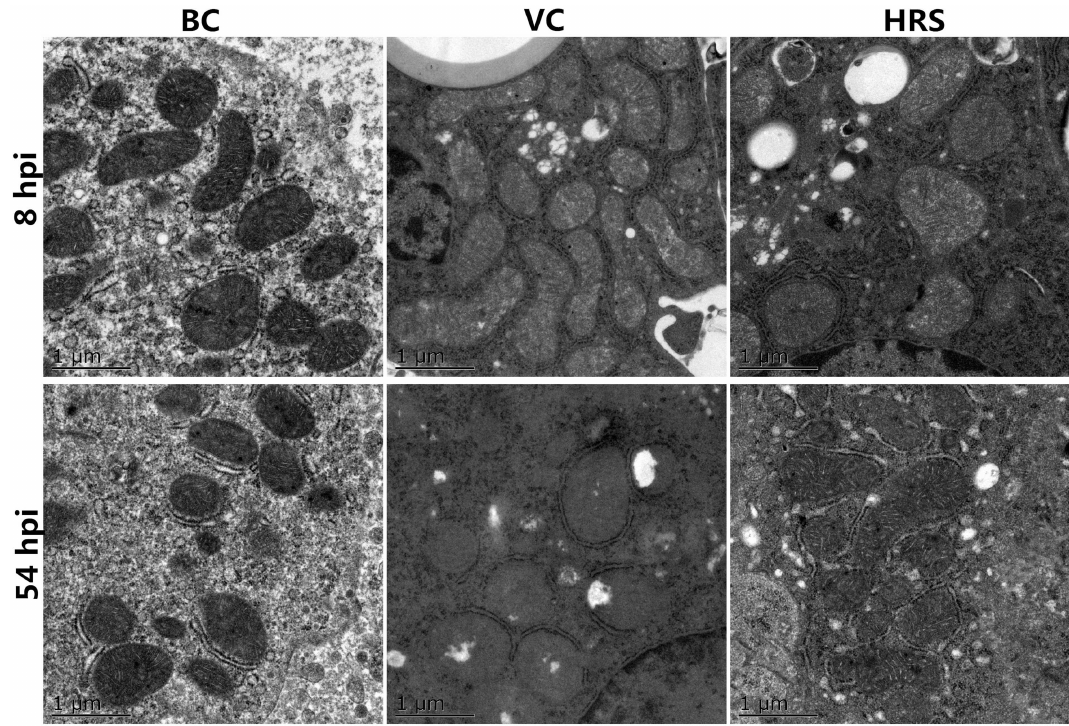
Fig 4. Changes of mitochondria ultrastructure at 8 hpi and 54 hpi (hpi: Hours Post-Injection). Liver tissue samples were obtained from individualducklingsof each group at the indicatedtime points, and the ultrastructure changesof liver mitochondria were analyzedby using TEM. Scale bar, 1 μ